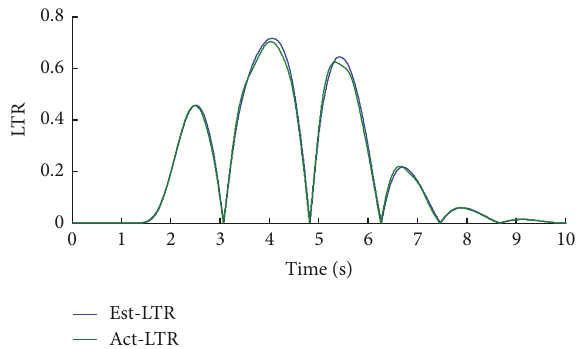
Figure 7: Estimated versus TruckSim LTR with 105 km/h